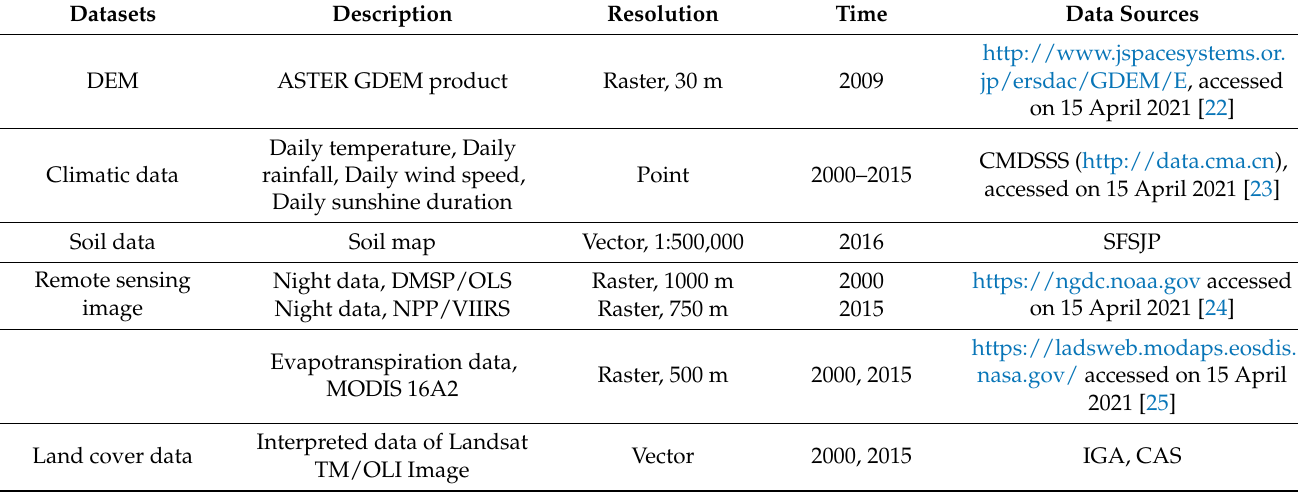
Table 1. Main data sources used in the